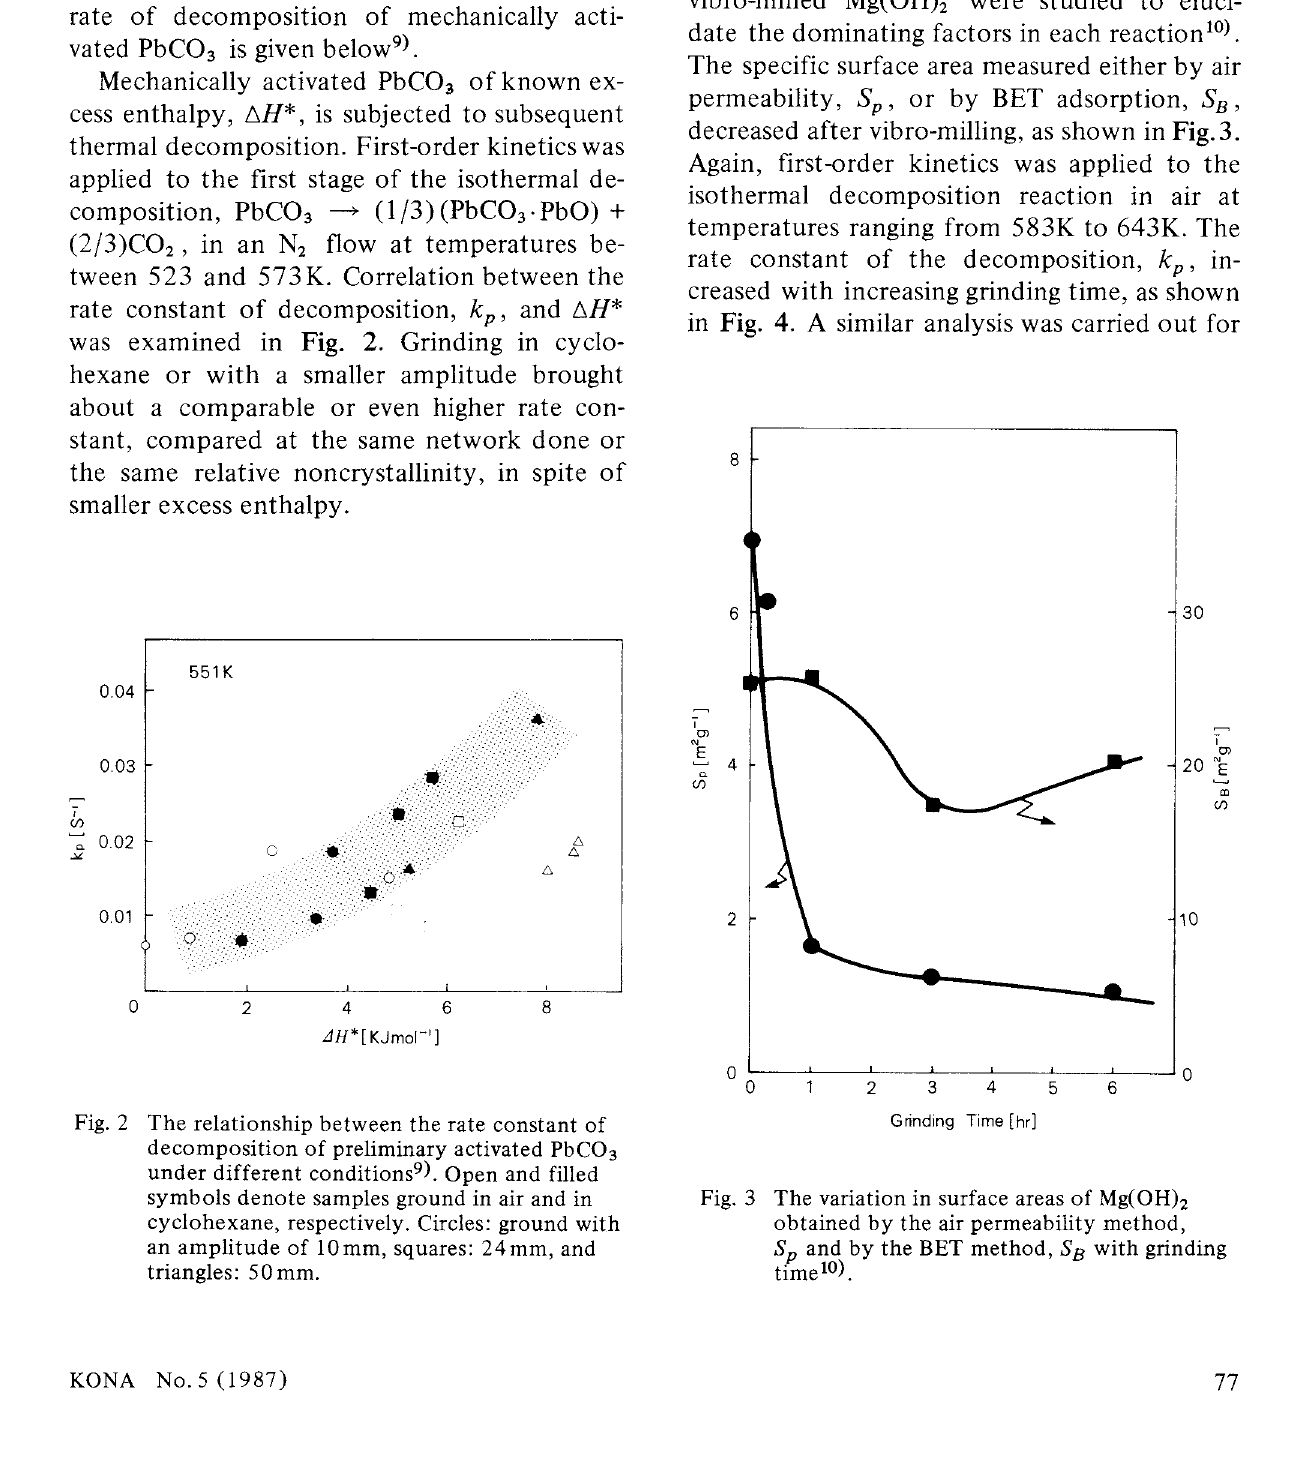
Fig. 2 The relationship between the rate constant of decomposition of preliminary activated PbC03 under different conditions 9). Open and filled symbols denote samples ground in air and in cyclohexane, respectively. Circles: ground with an amplitude of lOmm, squares: 24mm, and triangles: 50mm.